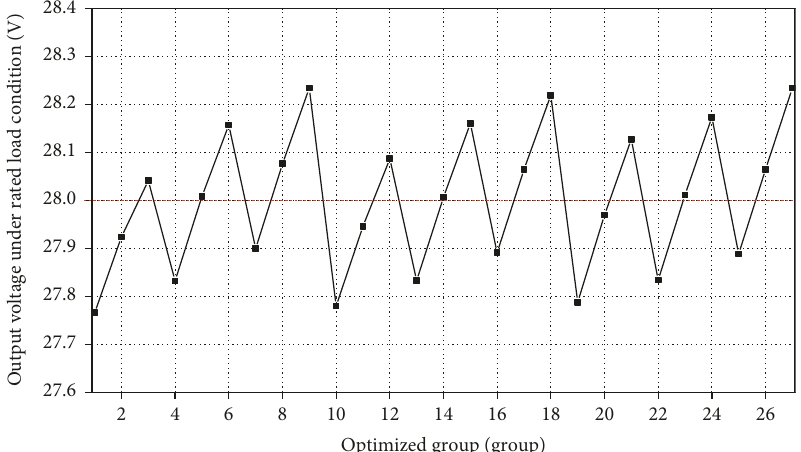
Figure 22: Variation curves of HEG output voltage under rated load conditions with different optimized groups.